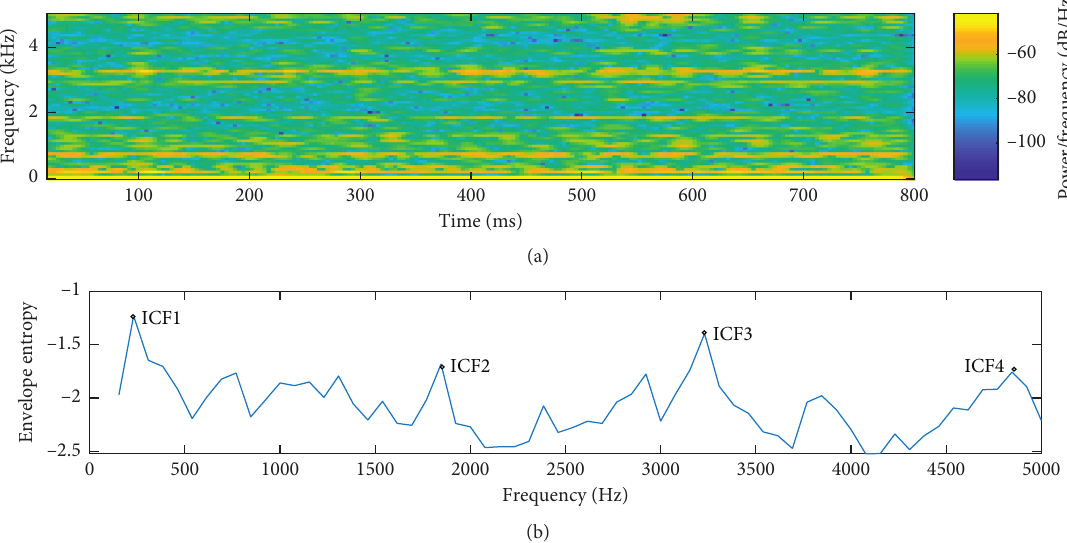
Figure 29: Spectral analysis of the multicomponents data in Figure 28(a) at window length 384 and overlap rate 90%: (a) TFR, (b) ENS.